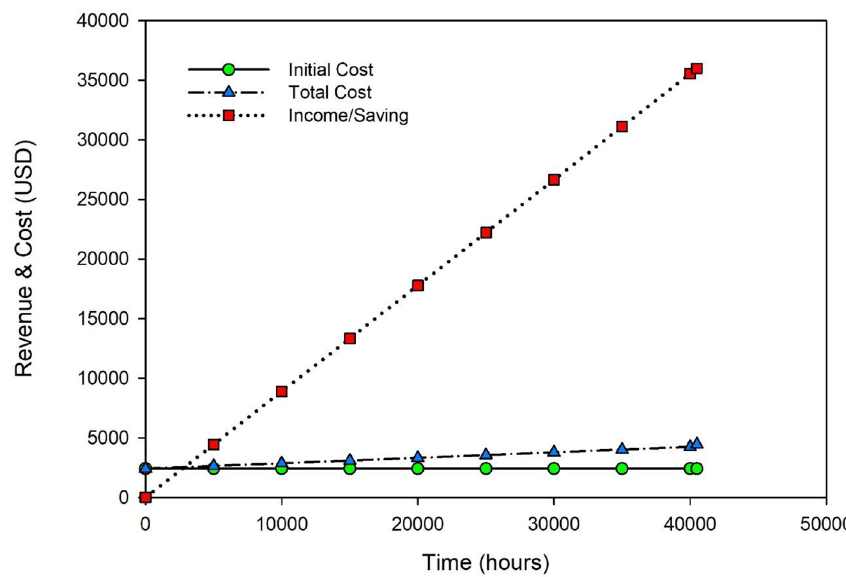
Figure 6. Break-even analysis for the yogurt processing unit in context with product